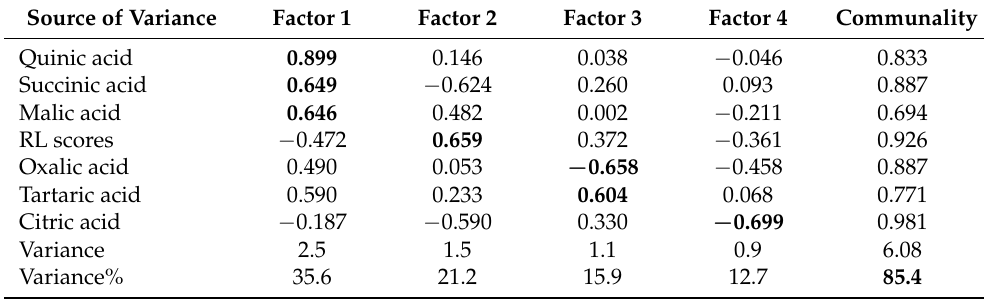
Table 5. Factor loadings (bold) and communalities of organic acids for principal factors in